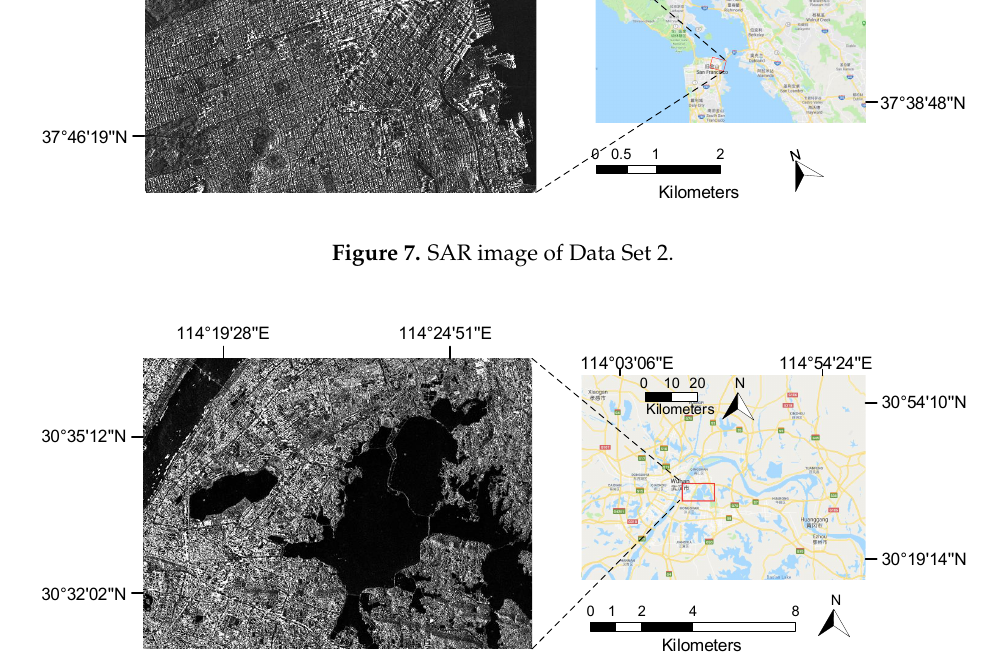
Figure 8. SAR image of Data Set